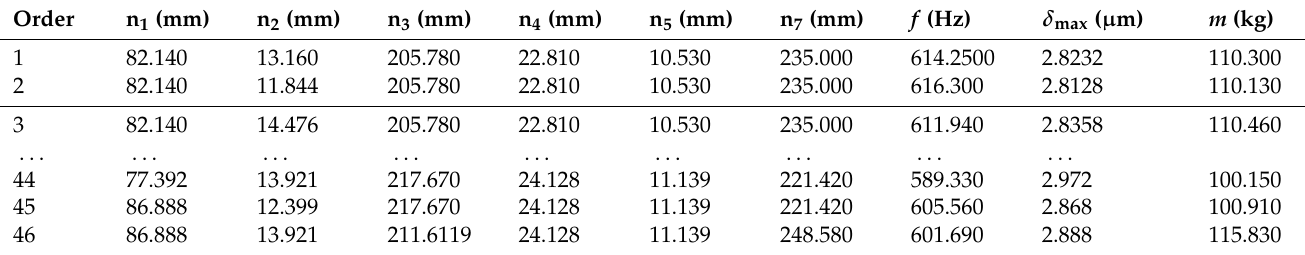
Table 7. Central composite design test point.